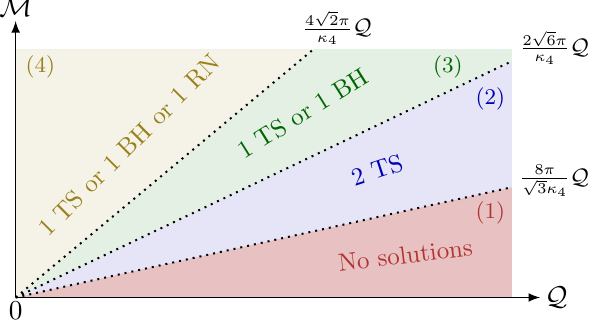
Figure 5 . Phase space of spherically symmetric solutions. “TS”, “BH” or “RN” stand for the topo- logical star of section 3.3, the black string of section 3.4 and the magnetic Reissner-Nordström (3.18) respectively. The graph should be read as “1 TS or 1 BH” = one topological star solution and one black string solution for the same ( M , Q )